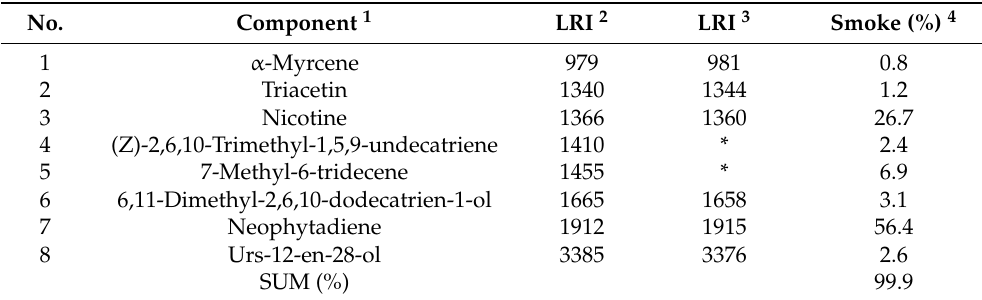
Table 2 . Chemical components (relative % ) of cigarette smoke condensate (CSC) identified at SPME- GC/MS analysis.